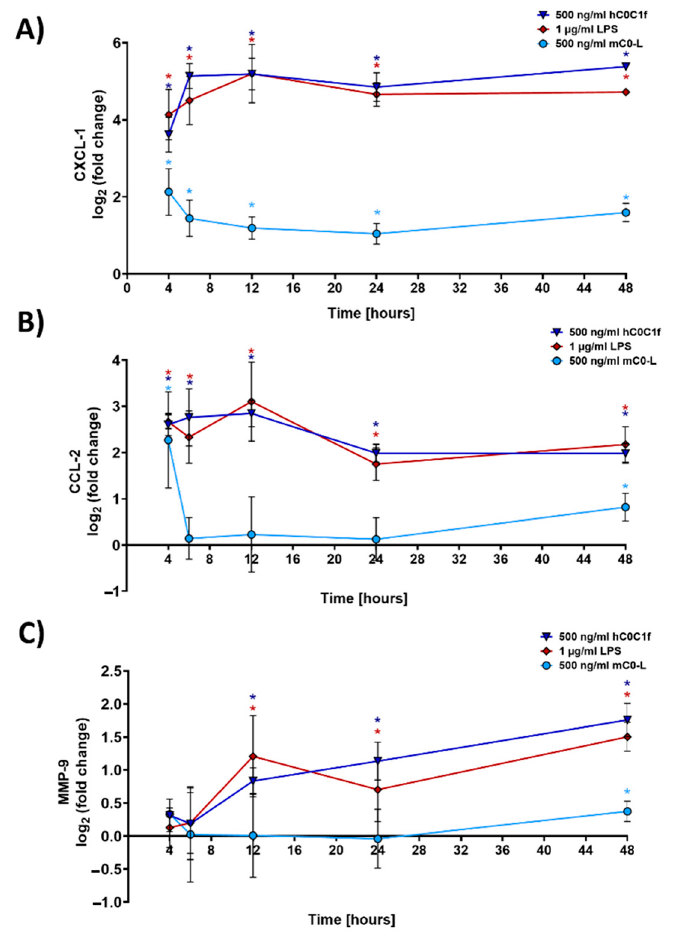
Figure 4. Time-dependent response of fibroblasts. huFib cells were treated with 500 ng/mL C0-C1f, 500 ng/mL C0-Linker or 1 µg/mL LPS for different time periods, and ( A ) CXCL-1, ( B ) CCL-2, and ( C ) MMP-9 mRNA abundance was quantified by qPCR. Data are displayed as mean ± SD ( n = 4 biologically independent experiments). * above each condition refer to differences between means (data points) and 0 fold change (unstimulated controls). * p < 0.05 was considered statistically significant.